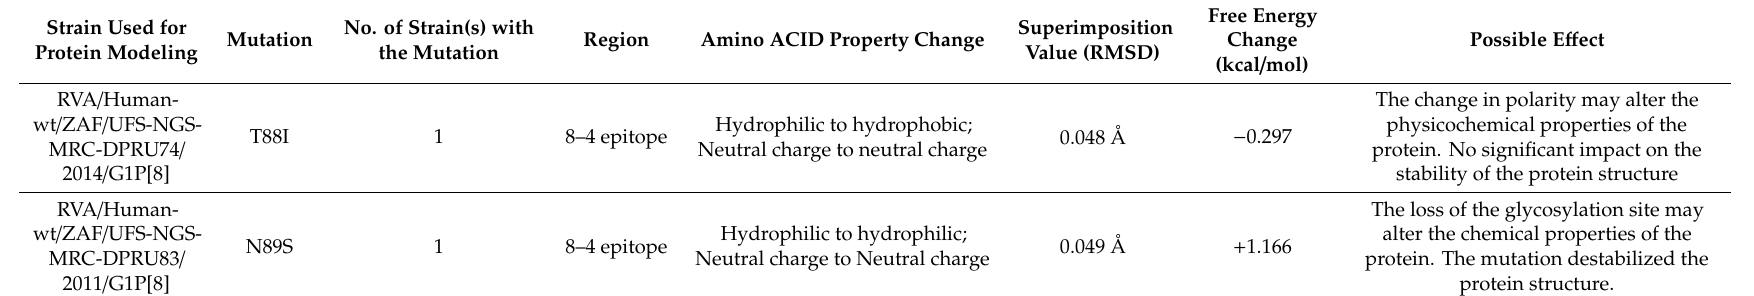
Table 3. Possible e ff ects of amino acid mutations in South African post-vaccine VP4 epitopes.